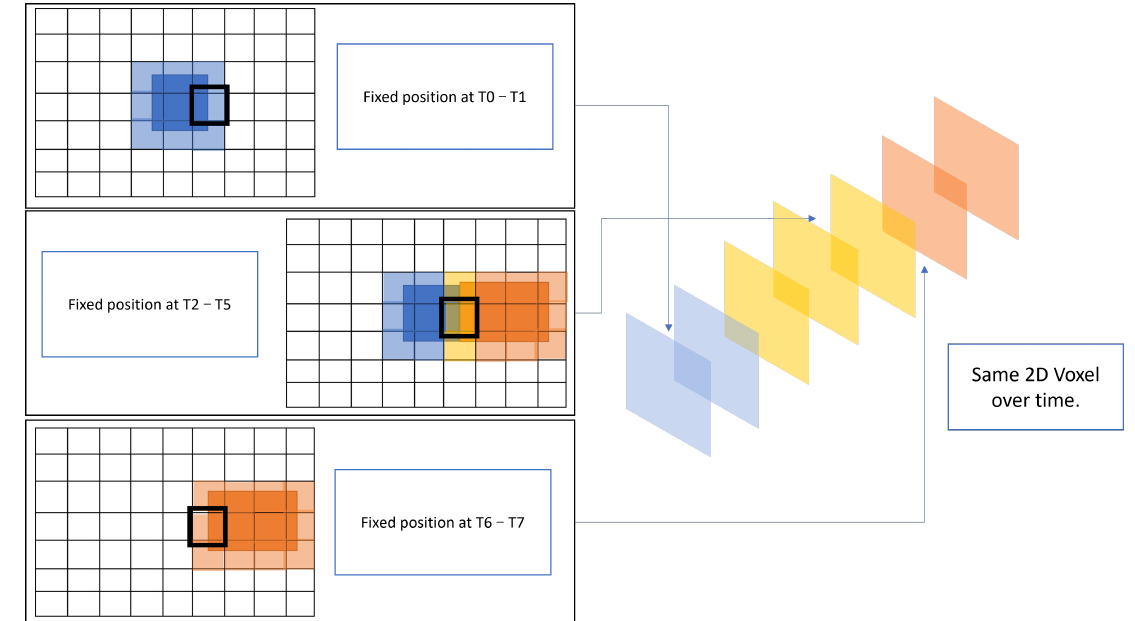
Figure 5. Figure showing how data of a single voxel are an array based on time. w = The size of the